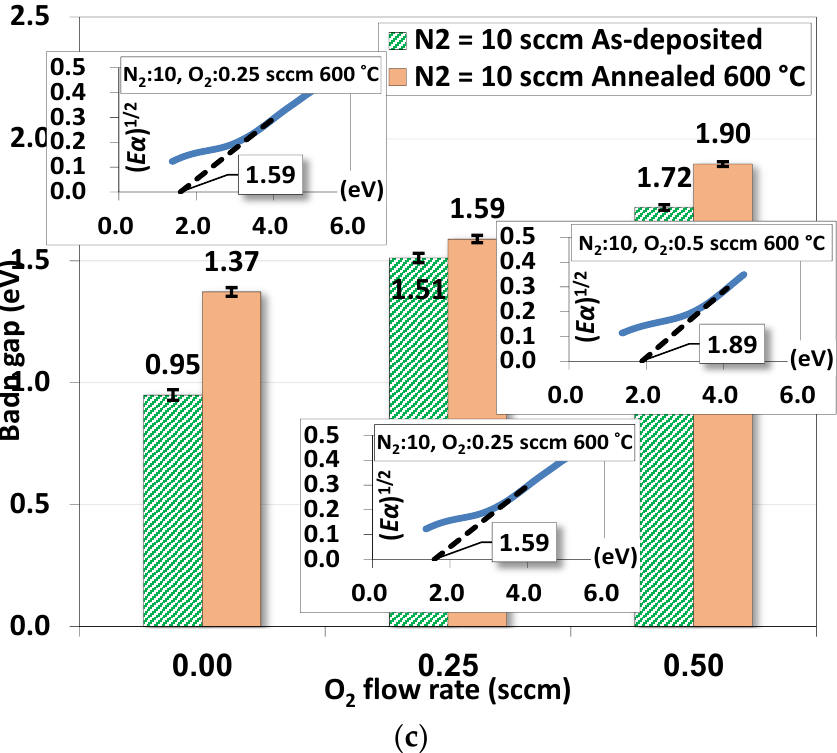
Figure 8. Estimated optical band gaps of as-deposited and annealed films at 600 °C for different oxygen/nitrogen flow rates ( a ) O 2 /N 2 = 0.15/3 sccm, ( b ) O 2 /N 2 = 0.25/5 sccm, and ( c ) O 2 /N 2 = 0.5/10 sccm.